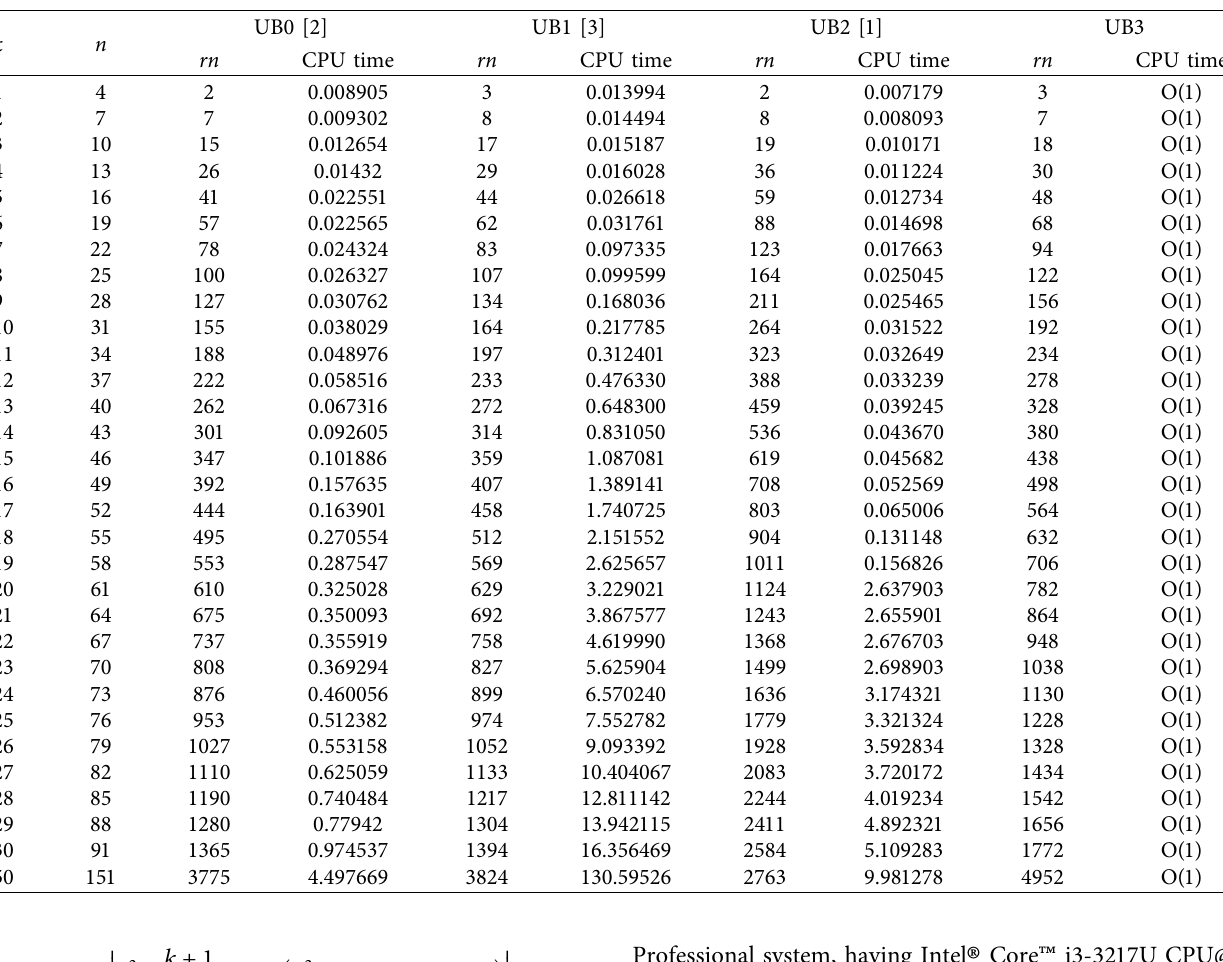
Table 2: Comparison between standard radio number and for the upper bound of the radio number for the double triangular snake